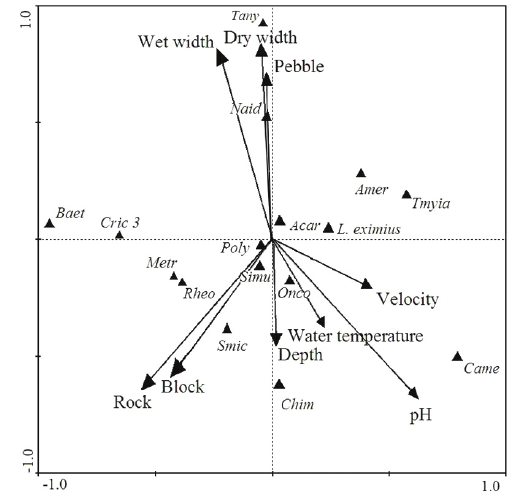
Figure 10. CCA ordination of benthic taxa and